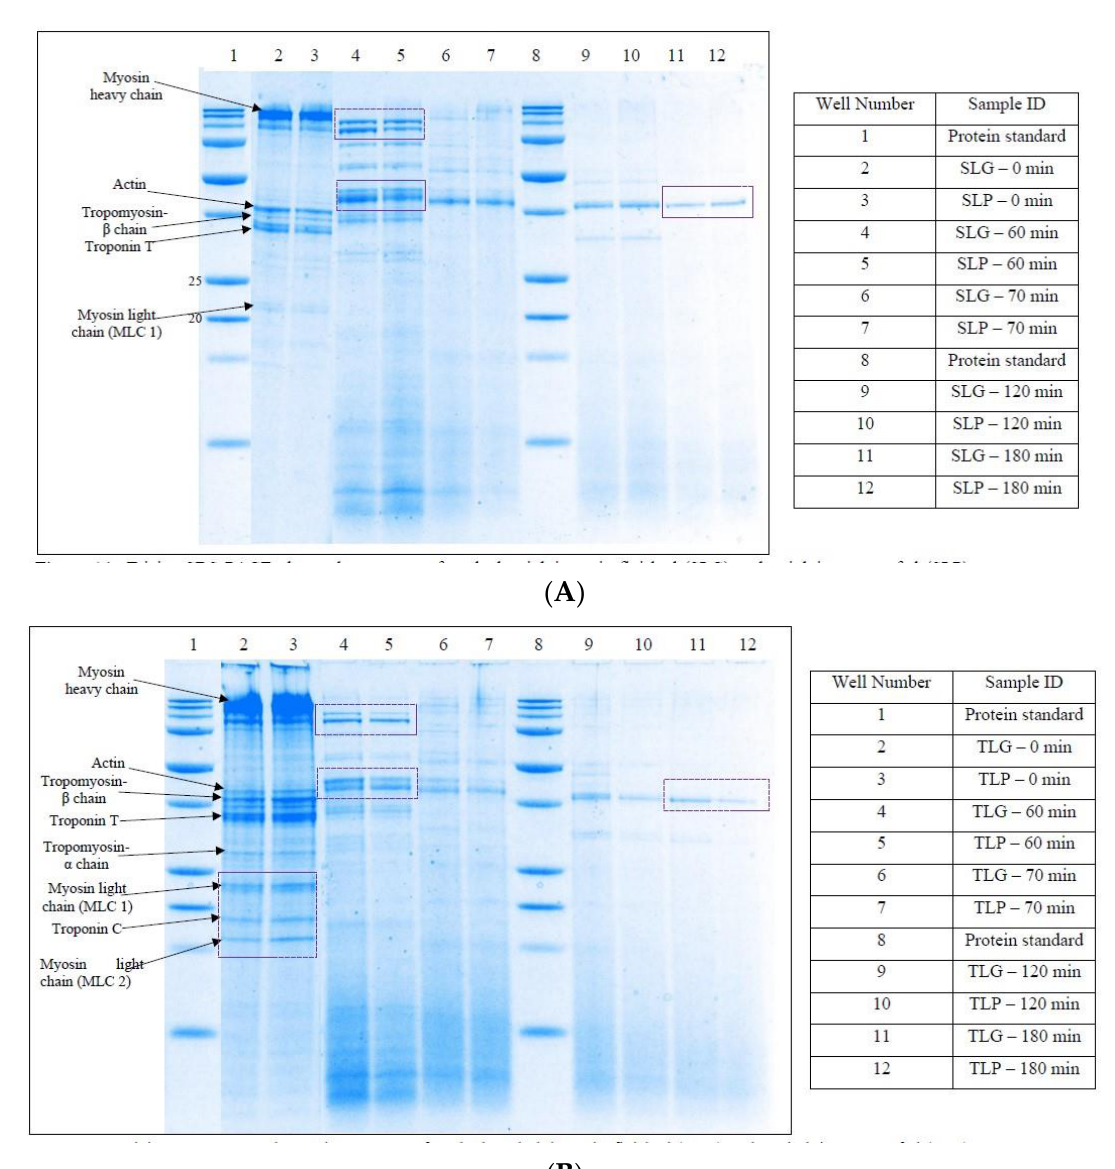
Figure 1. ( A ) Tricine SDS-PAGE electrophoretogram of cooked striploin grain-finished (SLG) and striploin pasture-fed (SLP) meat digests after 0, and 60 min of simulated oral-gastric digestion and 70, 120, and 180 min of simulated gastro-small intestinal digestion following initial 2 min of oral digestion. Bands in the molecular weight protein standard lane correspond to molecular weights 250, 150, 100, 75, 50, 37, 25, 20, 15, and 10 kDa. ( B ) Tricine SDS-PAGE electrophoretogram of cooked tenderloin grain-finished (TLG) and tenderloin pasture-fed (TLP) meat digests after 0, and 60 min of simulated oral-gastric digestion and 70, 120, and 180 min of simulated gastro-small intestinal digestion following initial 2 min of oral digestion. Bands in the molecular weight protein standard lane correspond to molecular weights 250, 150, 100, 75, 50, 37, 25, 20, 15, and 10